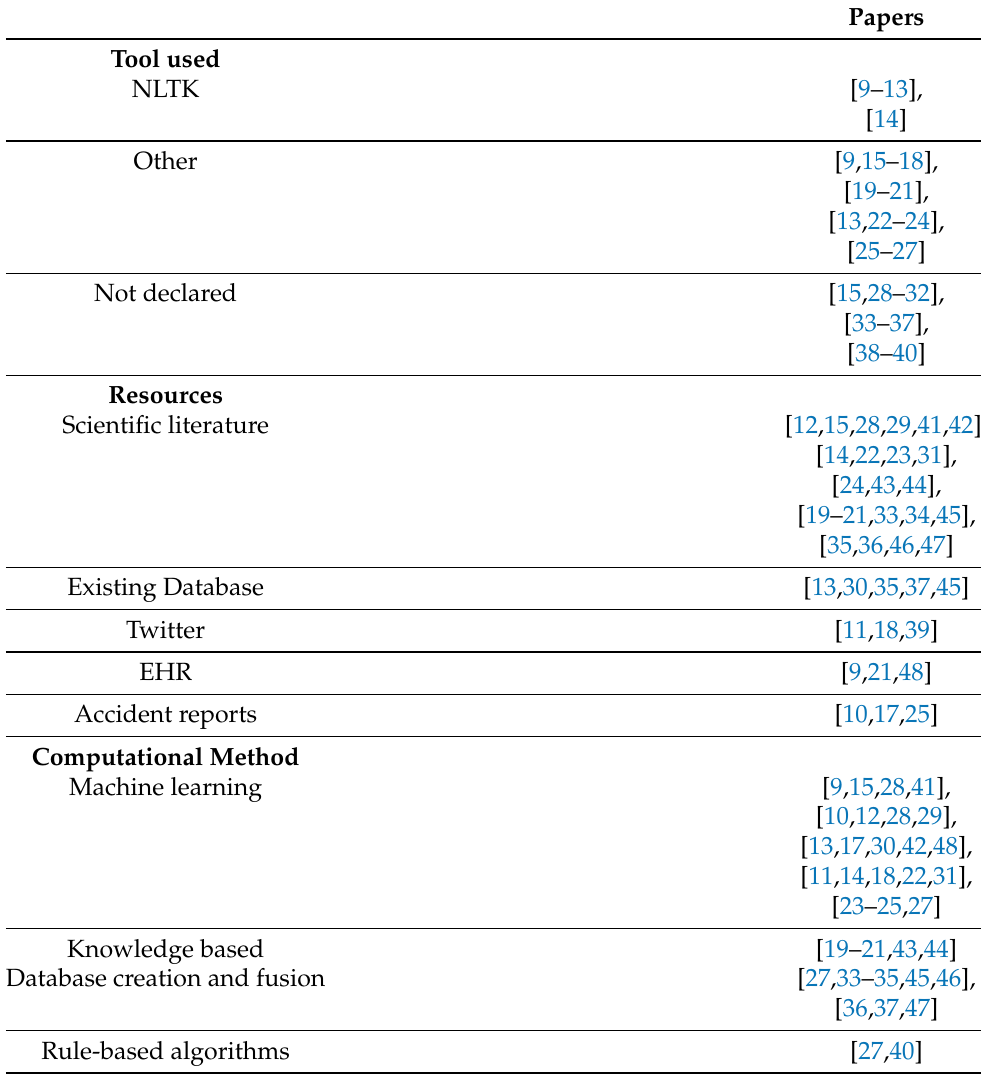
Table 1. A categorisation of each paper based on tools used , resources and computational methods